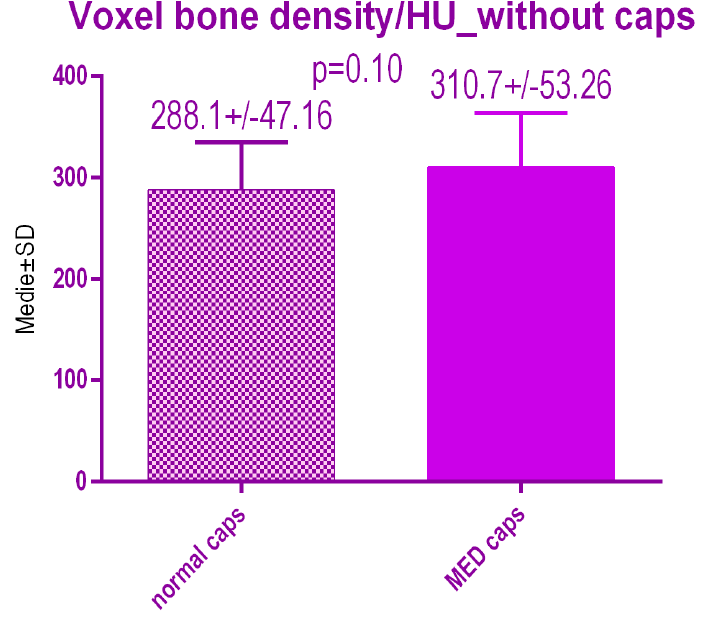
Figure 18. Bone radiodensity in the study groups before treatment.